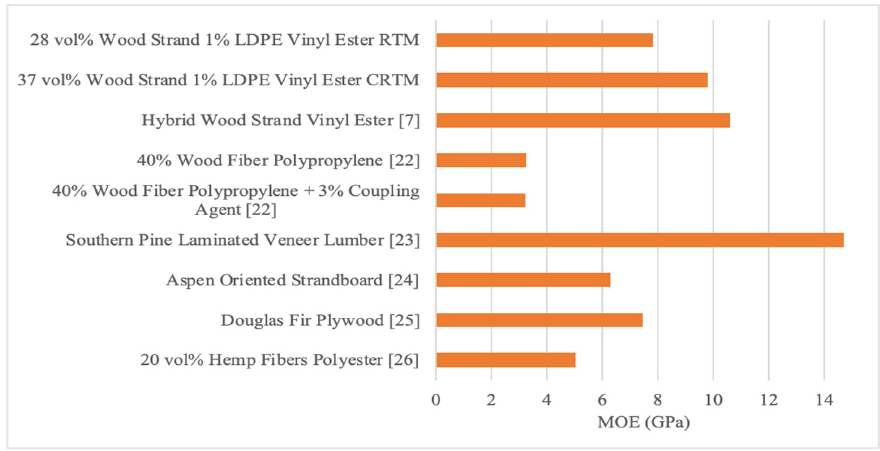
Figure 13. Bending modulus properties of RTM and CRTM wood strand panels compared to other panels from published data ([7,22–26]).